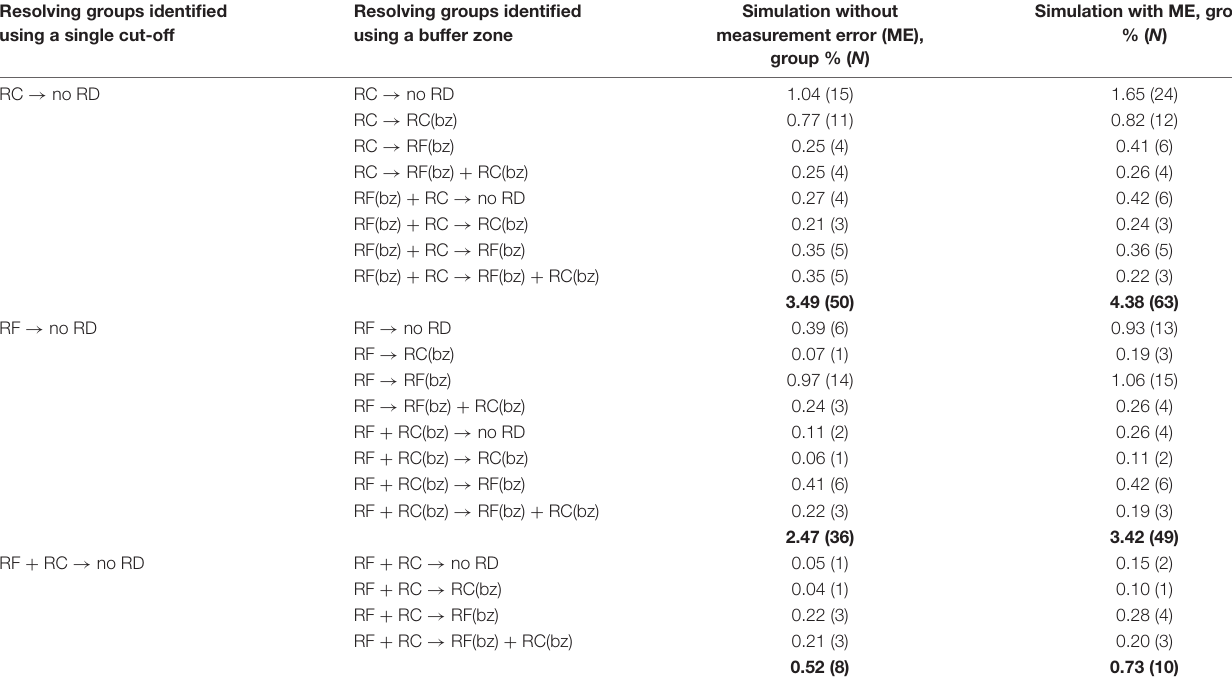
TABLE 8 | Percentages and number of individuals of the resolving groups identified with the use of a buffer zone. Resolving groups identified using a single cut-off